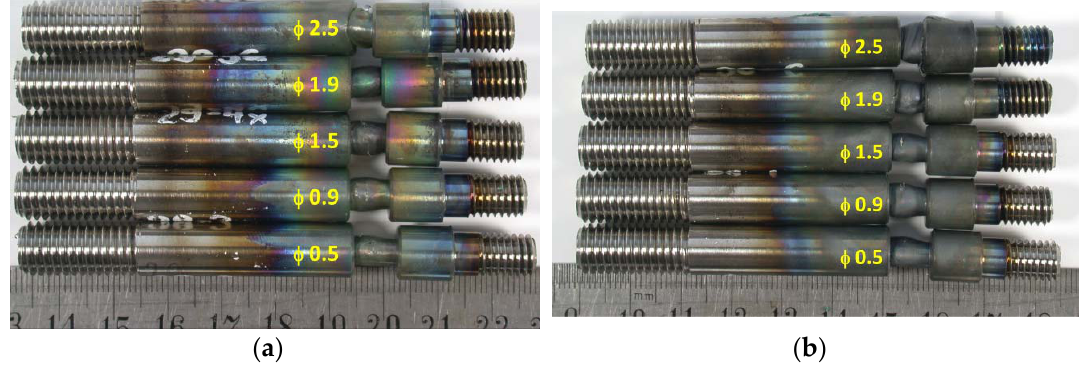
Figure 4. Thermomechanically ‐ treated specimens: ( a ) MoNiCr; ( b ) HN80MTY.